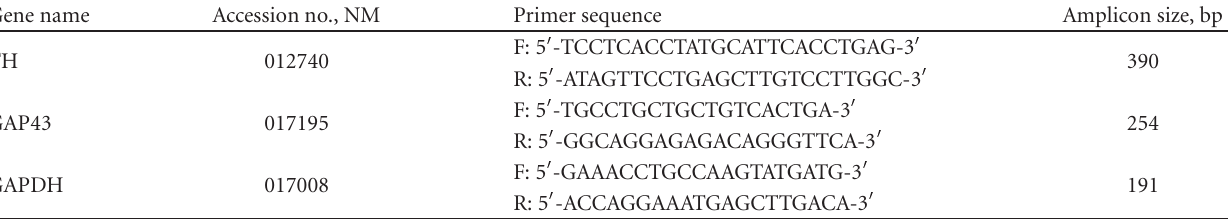
Table 2: Infarct size and VFT in the four groups (mean